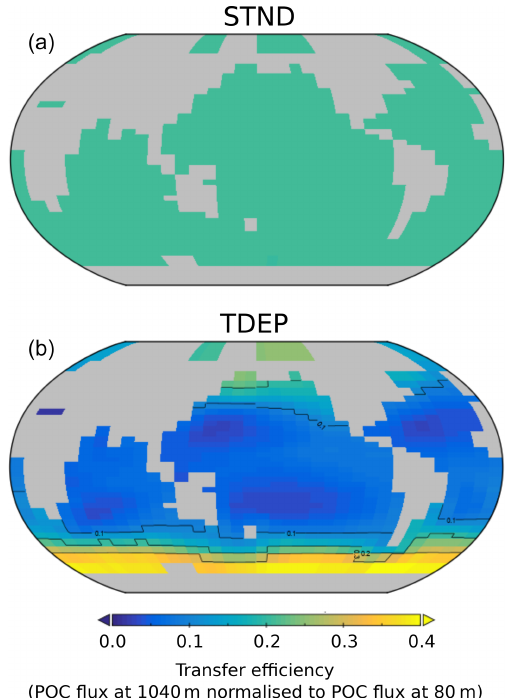
Figure 13. Model POC transfer efficiency (also used as a measure of biological carbon pump efficiency here) for STND (a) and best- fit TDEP (b) . Transfer efficiency is the fraction of POC exported at 80m that reaches 1040m for the year 2010. The global transfer efficiency value for STND is